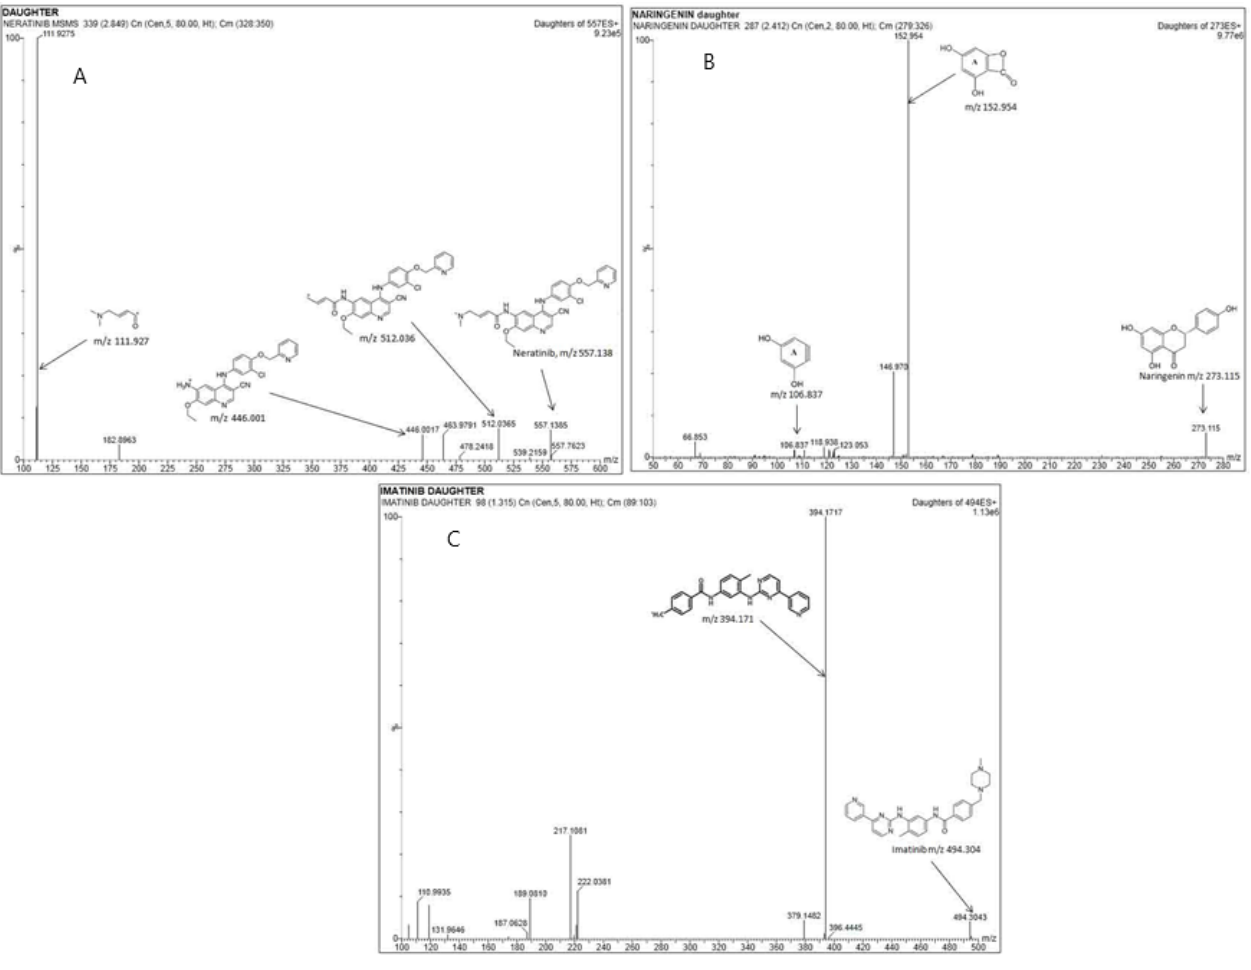
Figure 2. Representative parent to daughter ion MRM transitions and the fragmentation products formed for ( A ) NER, ( B ) IS, and ( C ) NRN at LLOQ.